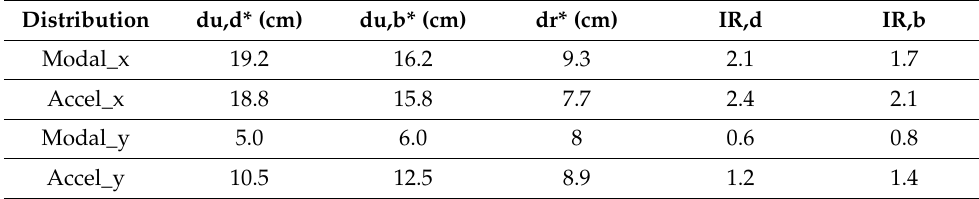
Figure 6. Seismic checks in the ADRS plane: ( a ) modal_x; ( b ) accel_x; ( c ) modal_y; ( d ) accel_y. Table 1. Safety